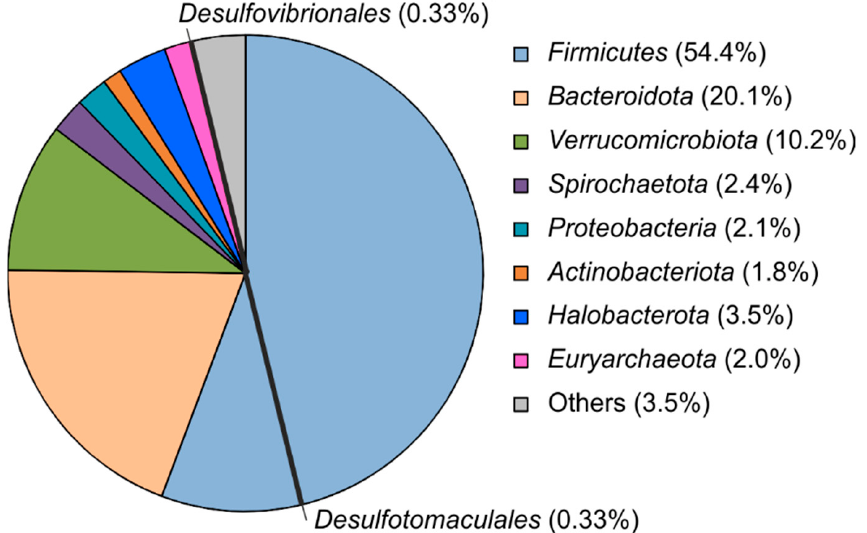
Figure 3. Microbial communities of camel feces at the phylum level and sulfate-reducing lineages ( Desulfotomaculales and Desulfovibrionales ). Relative abundances (% of the total 16S rRNA gene sequences, average of 55 samples) are shown after taxon names.